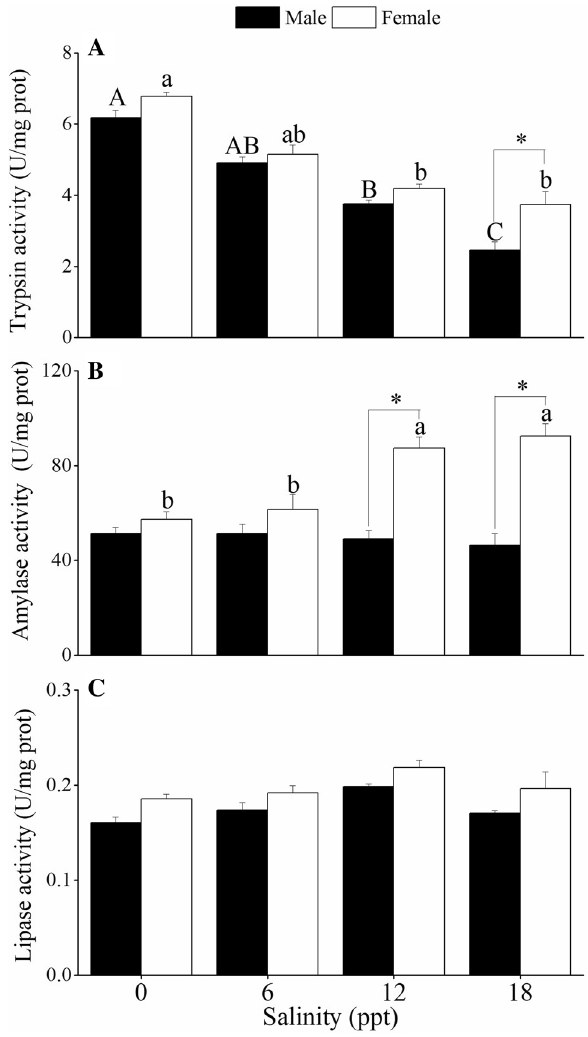
Figure 3. Effects of salinity exposure on the activities of trypsin (A) , amylase (B) and lipase (C) in the hepatopancreas of male and female C. dehaani crabs. Values are mean ± SE, N = 4. Different letters above the data indicate significant differences between the salinity treatments, as assessed using Tukey’s tests ( P < 0.05). * indicates significant differences between female and male crabs, as assessed using Tukey’s tests ( P <